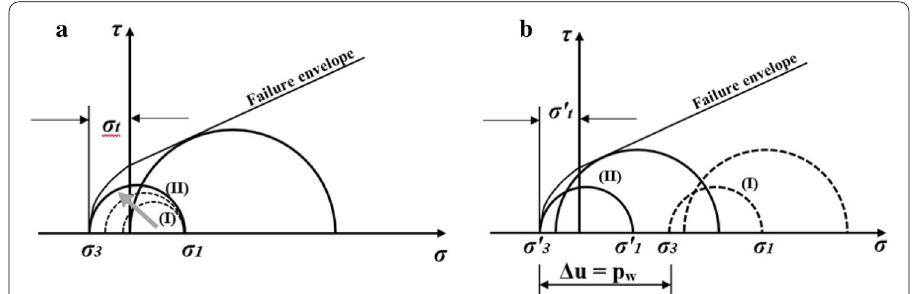
Fig. 1 Mechanism of hydraulic fracturing in earth dams explained through Mohr’s circles based on a differential settlement b development of seepage-induced pore-water pressure